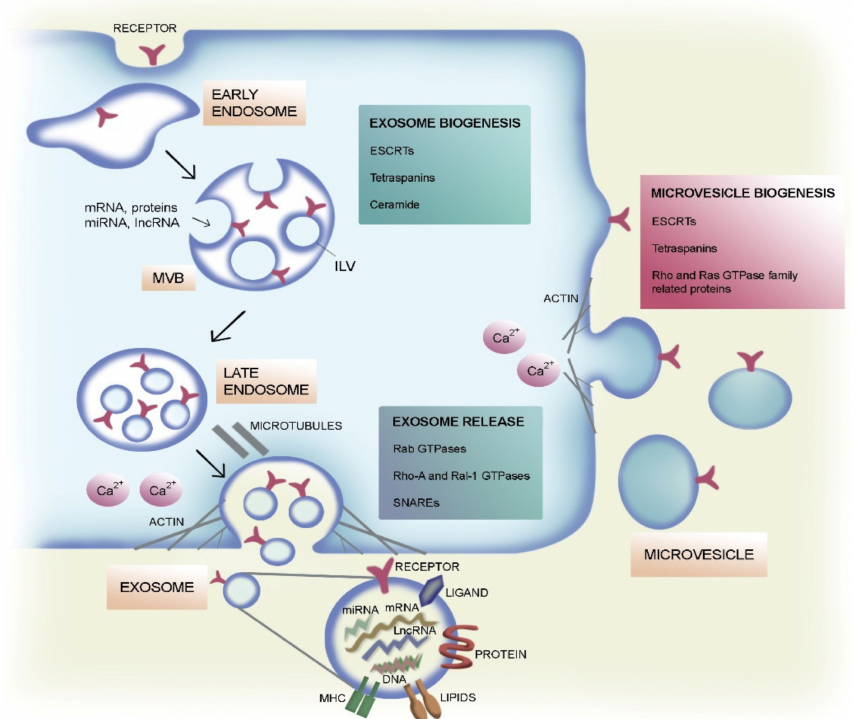
Figure 1. Extracellular vesicle (EV) biogenesis and secretion. Schematic representation of the formation and release of exosomes and microvesicles (MVs) by eukaryotic cells. Exosomes arise from intraluminal vesicles (ILVs) by budding into early endosomes and multivesicular bodies (MVBs). Several molecules are involved in ILV formation, in particular, lipids (e.g., ceramide) and proteins like tetraspanins (e.g., CD63, CD81, and CD9) and the endosomal sorting complex required for transport (ESCRT) machinery with its associated factors hepatocyte growth factor-regulated tyrosine kinase substrate (HRS), tumor susceptibility gene 101 protein (TSG101), apoptosis-linked gene-2 interacting protein X (ALIX), and vacuolar protein sorting-associated protein 4 (VPS4). Several Rab small guanosine triphosphatases (GTPases) (e.g., Rab11, Rab27a / b, and Rab35) contribute to transportation of MVBs to the plasma membrane, thus eliciting the exosome secretion. Other proteins involved in MVB fusion with the plasma membrane are Rho-A, Ral-1, and soluble N-ethylmaleimide-sensitive factor attachment protein receptors (SNAREs). Many of these proteins also participate in MV biogenesis, such as TSG101 through the interaction with arrestin domain-containing protein-1 (ARRDC1). Proteins associated to the Rho (ROCK) and the Ras GTPase family (ARF1, ARF6) also contribute to MV generation by controlling cytoskeleton rearrangements. Furthermore, a rise in calcium intracellular levels contributes to EV secretion. The molecular content of exosomes is also